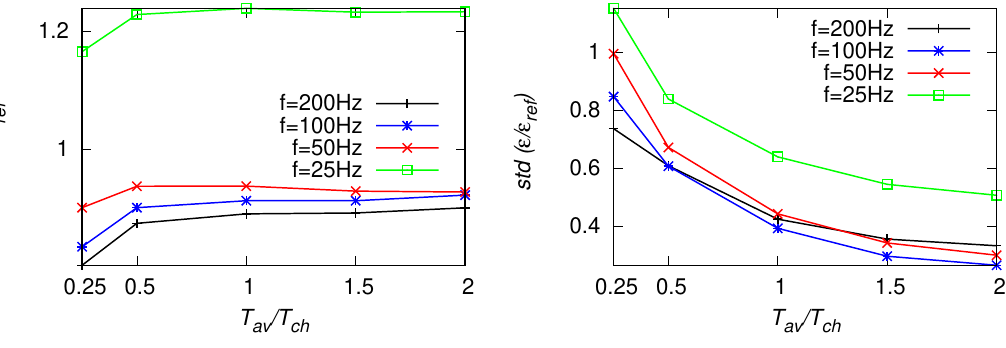
Figure 13. Statistics of (cid:101) NCF estimates based on the number of zero-crossing scaling, Equation (9), for the fitting range f = [ 10 ÷ 20 ] Hz, from artificial signals with f s = 200 Hz, 100 Hz and 50 Hz. Left panel : EDR averaged along the signal, right panel : standard deviation of the estimates.